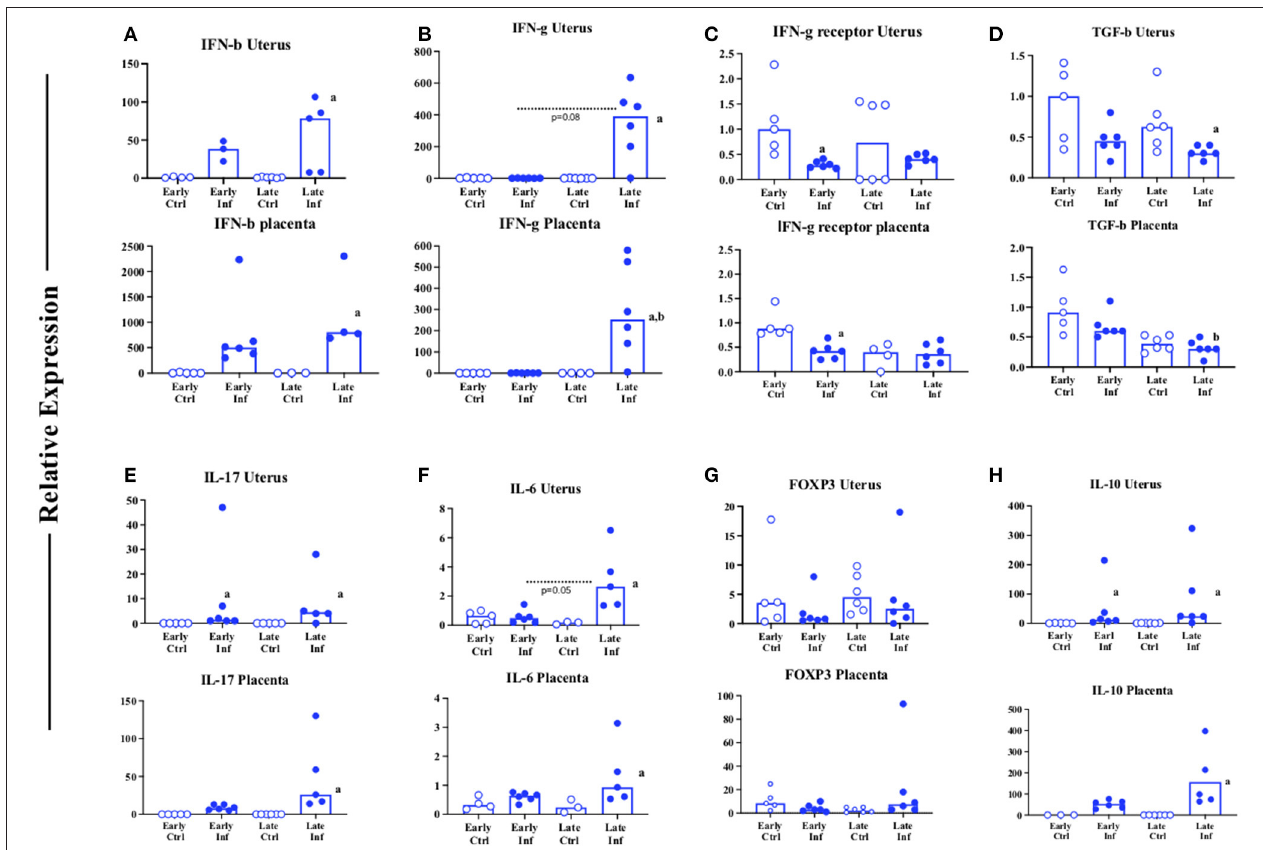
FIGURE 1 | Cytokine profile of uterine and placental tissues in normal mice infected with LCMV during pregnancy. C57BL/6 (B6) mice were infected (closed symbols) or not infected (open symbols) ip with 2 × 10 5 pfu of LCMV Armstrong on day 10 of pregnancy. (A–H) Values for the uterus (top) or the placenta (bottom) of the samples collected. ∼ Day 12 (early), or ∼ 18 (late) of pregnancy the mice were euthanized, and the tissues indicated were tested by QT-PCR for expression. Y axis: relative expression using the 11 CT method compared to sample from an unmanipulated animal. X axis: time grouping. Each symbol represents an individual sample from an individual (distinct) mother ( n = 4–6 mothers). Inf denotes samples from an infected mouse while Ctrl denotes samples from an unmanipulated mouse. Data was analyzed using Kruskal Wallis test with Dunn’s correction for multiple comparisons testing. Letters: a denotes significance (e.g., p < 0.05) when comparing infected to control samples obtained at the same gestational age; b denotes significance between samples obtained early or late post infection. Trends ( p < 0.1) are noted